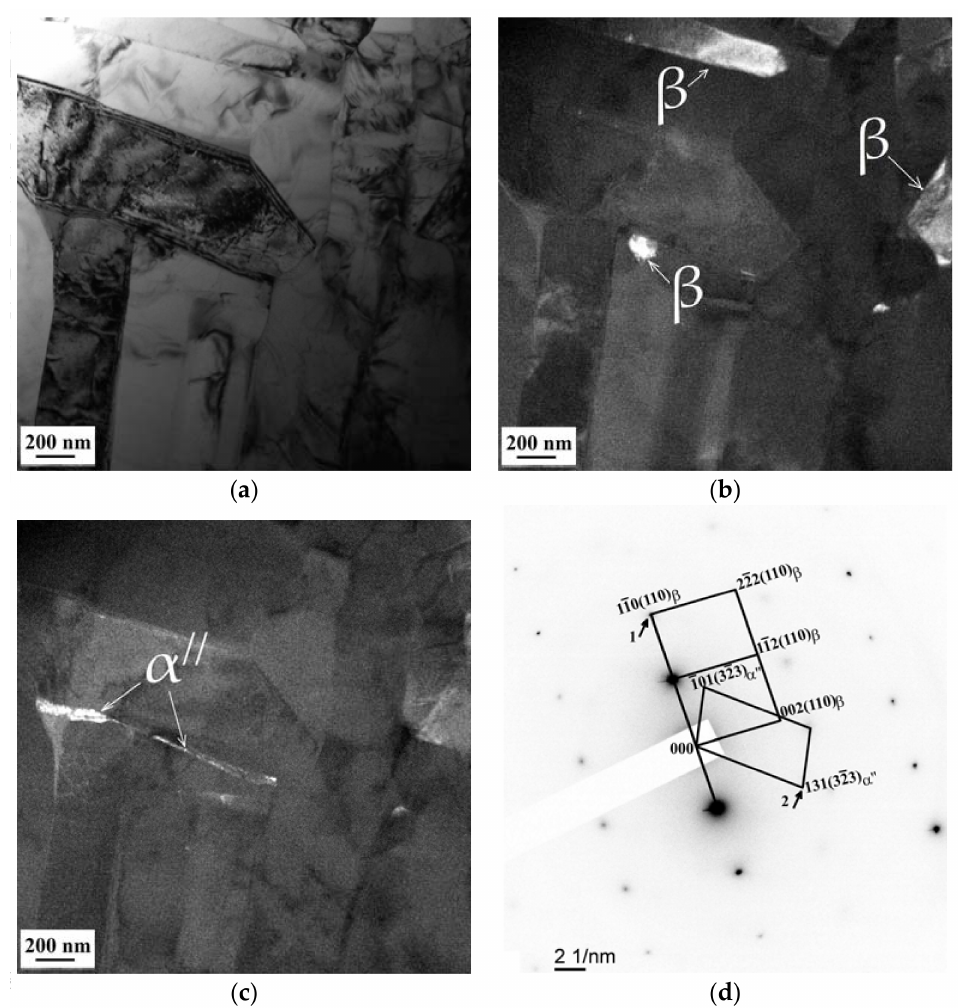
Figure 5. TEM bright- ( a ) and dark-field images ( b , c ) and associated SAED pattern ( d ) of the microstructure of EBM titanium Ti-6Al-4V parts; b—the dark-field image obtained with 110 β -Ti reflection (marked by an arrow 1); c—the dark-field image obtained with 131 α ”-Ti reflection (marked by an arrow